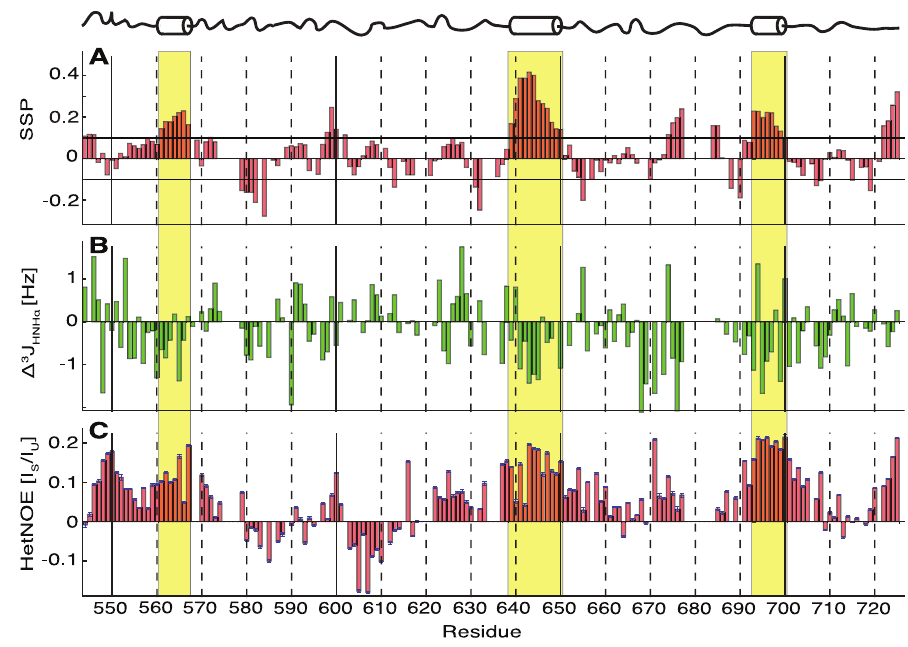
Fig 3. Secondary structureand flexibilityanalysisof Nogo-A- Δ 20. A : Secondarystructurepropensities for single residues. Threeresidual α -heliceswere found as definedby five or more consecutive residueswith SSP values above 0.1 (yellow boxes). B : Δ 3 J HNH α derived fromthe difference between 3 J HNH α measured fromintensitymodulated[ 15 N, 1 H]-HSQCexperimentsand corresponding randomcoil values [29].Negative Δ 3 J HNH α indicatean α -helicalwhile positive values indicatean extended conformation,respectively. C : 15 N { 1 H}-HetNOEs. A value near 1 indicatesa fully rigidconformation,values close to zero indicate the presence of ~1 ns dynamics, while negative values indicatethe presenceof even faster motion.Most of the values are positive between the ratios 0.1–0.2.Only two consecutive strands between the residues580–588and 603– 614 have negative values. Errorbars were calculatedusing Gaussianerrorpropagation. The locationsand secondary structure propensityof α -helicesas determined by NMR (see text) are indicatedabove the diagrams. The cylinders/yellow boxes indicatetransient α -helicalpropensities. Residuesbelongingto the affinitytags flankingNogo-A- Δ 20 are not plotted.